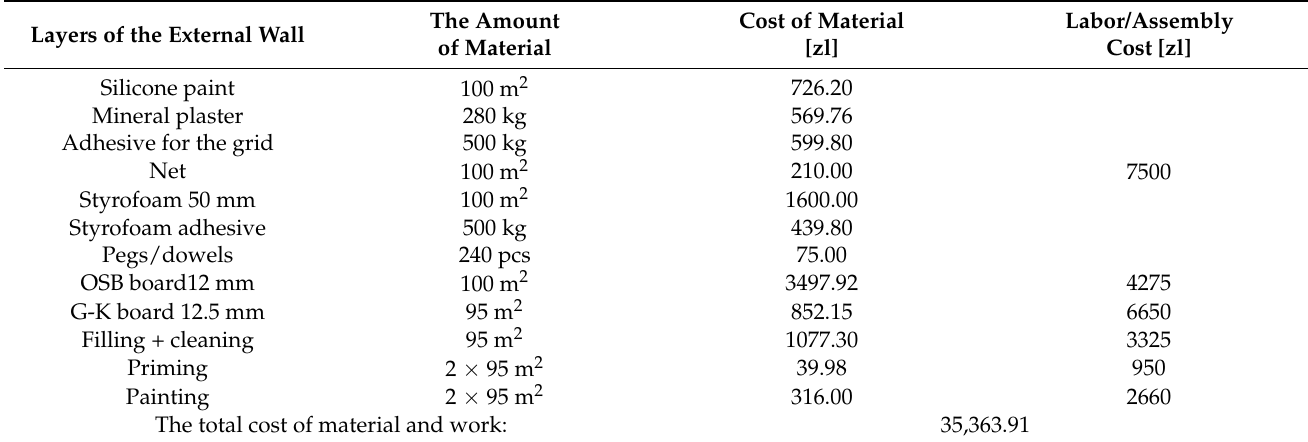
Table 2. The cost of finishing external walls using Canadian technology according to the Polish prices in zlotych (PLN).